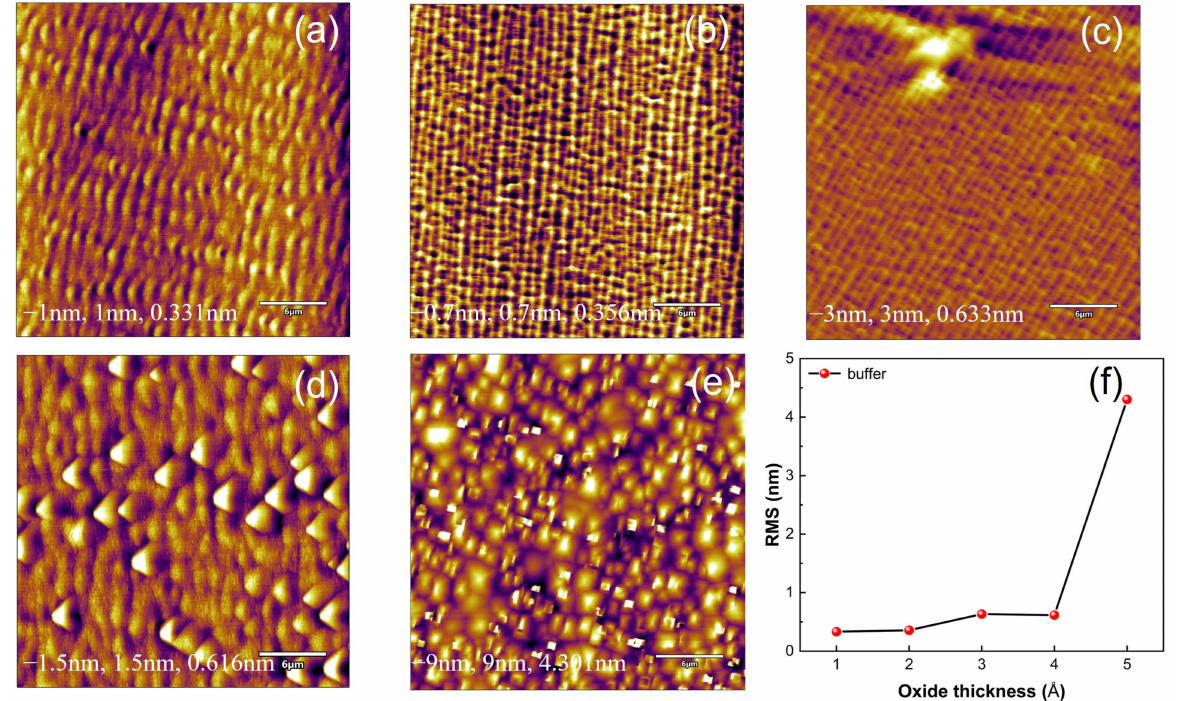
Figure 5. AFM images of epitaxial buffer layers on substrates with different native oxide layer thicknesses. At the bottom of the figure are valley and peak heights and RMS roughness. ( a ) Thickness of oxide layer is 18.21 Å; ( b ) thickness of oxide layer is 38.34 Å; ( c ) thickness of oxide layer is 55.76 Å; ( d ) thickness of oxide layer is 115.63 Å; ( e ) thickness of oxide layer is 224.71 Å; ( f ) surface RMS in sample ( a – e ).